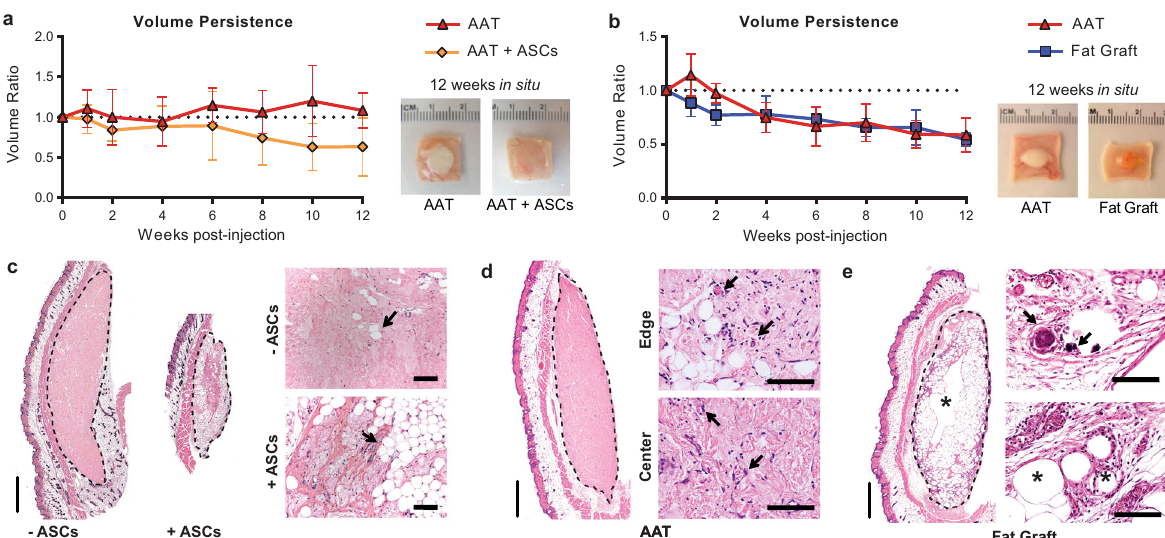
Fig. 2 AAT demonstrates volume retention and superior biocompatibility in athymic mice. a Volume persistence in AAT versus in AAT supplemented with ASCs when implanted in athymic nude mice ( n = 12 per group), with gross images of recovered implants after 12 weeks in situ. b Volume retention for human lipoaspirate (fat grafting) and AAT injected subcutaneously in athymic nude mice ( n = 6 per group), as measured trans-dermally using digital calipers, with gross images of recovered implants after 12 weeks in situ. c – e H&E staining of implants recovered after 12 weeks, with implant boundaries indicated by dashed lines. c New adipose tissue formation (arrows) within ASC-containing AAT implants. d Adipogenesis and vascularization (arrows) within the AAT implant. e Signs of calci fi cation (arrows) and cyst formation (*) within fat grafts. Error bars represent ±1 standard deviation. Scale bars represent 1 mm in whole sections and 100 µm in enlarged